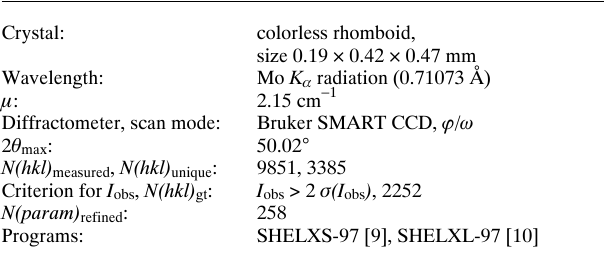
Table 1. D a t a collection a nd h a